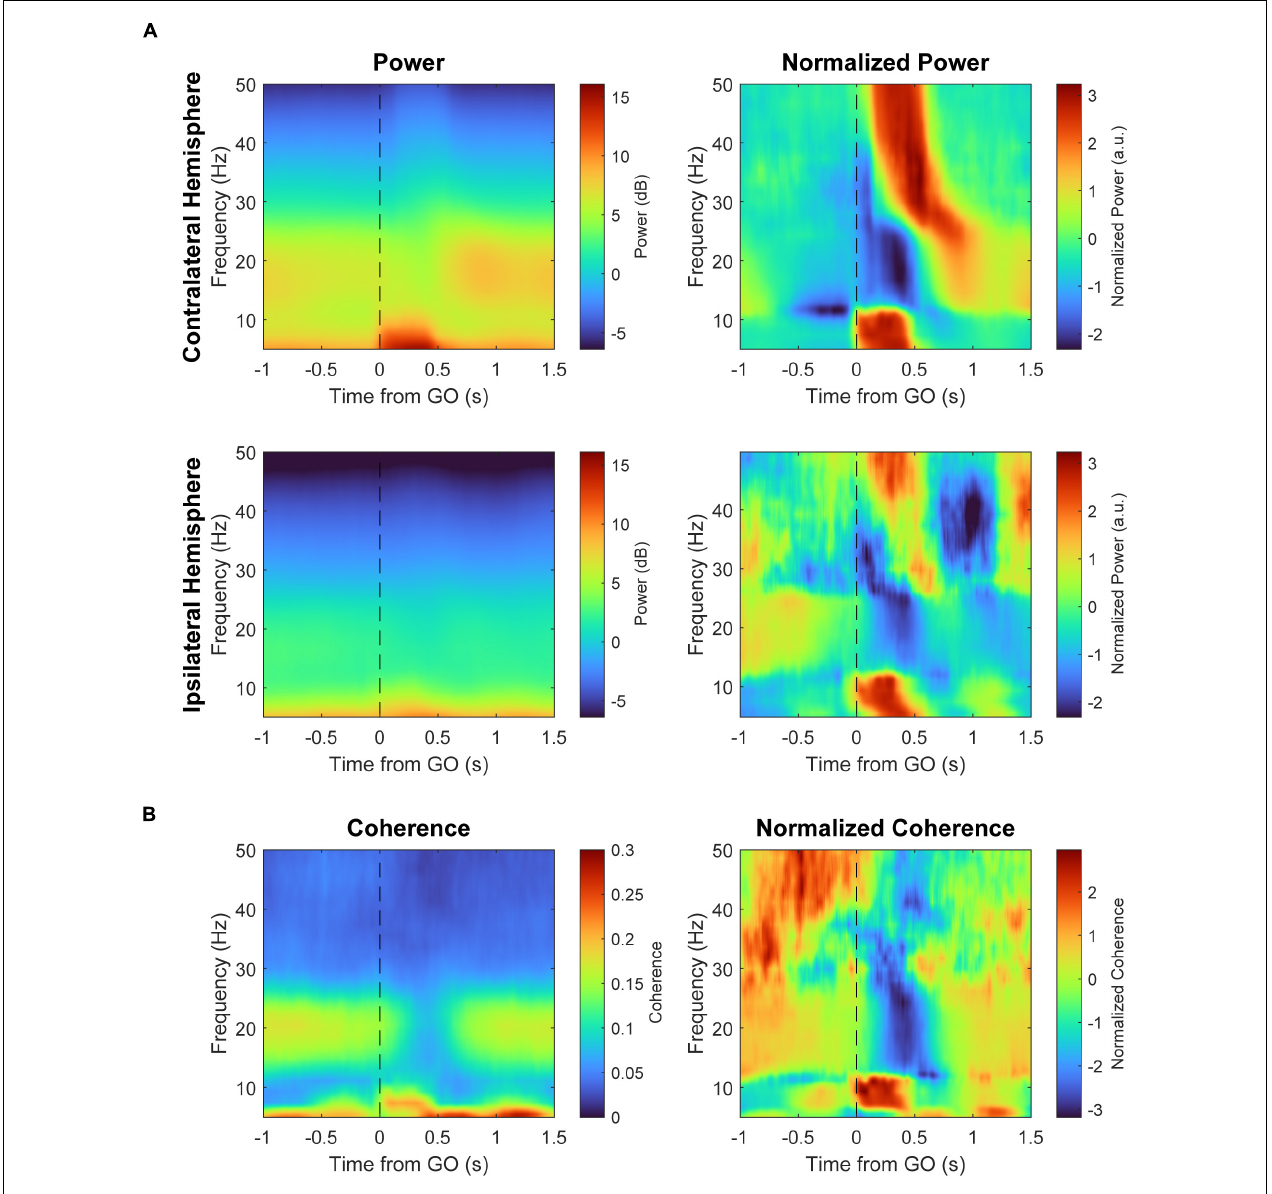
FIGURE 8 | Spectral power and coherence during a trial. (A) Spectral power during behavior with respect to the GO signal of the contralateral (top) and ipsilateral hemispheres (bottom) during a Pre epoch, averaged across all three monkeys. The right panels show the spectra normalized across time for each frequency (z-score) to highlight frequency-specific changes over time. (B) Coherence between the two hemispheres with respect to the GO signal. The right panel shows coherence normalized across time for each frequency.